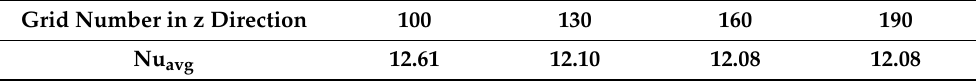
Table 5. Average Nusselt number for concentric state with several axial grid number. Grid Number in z